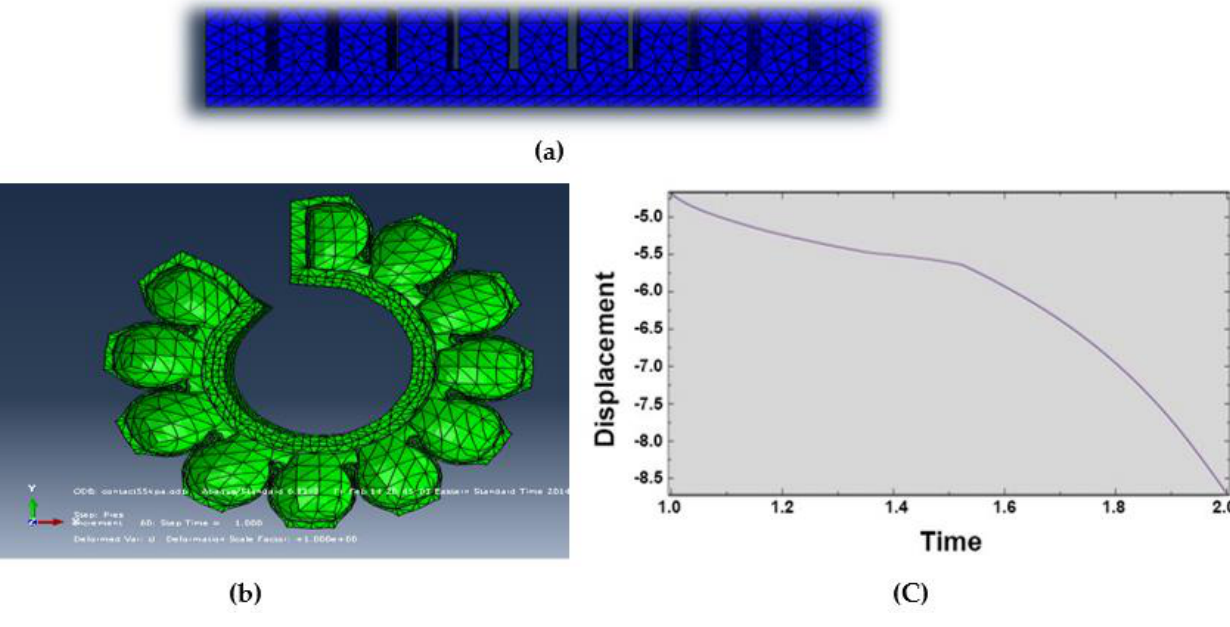
Figure 5. ( a ) Meshing of SPA; ( b ) Deformation of SPA; ( c ) Curvature in three-dimension